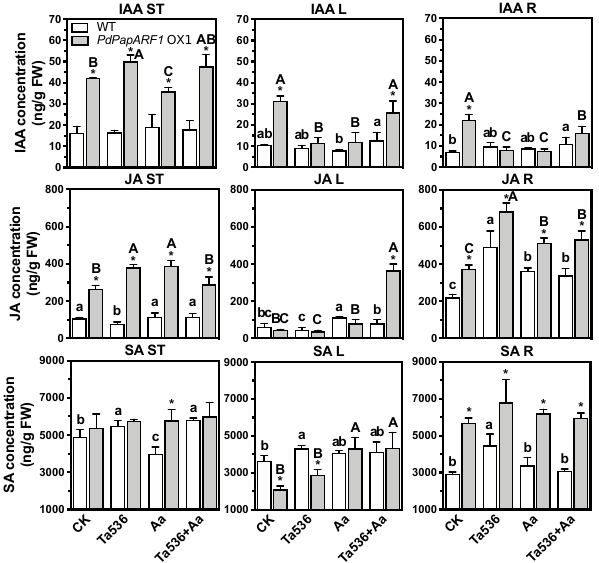
Figure 4. The concentrations of indole acetic acid (IAA), jasmonic acid (JA), and salicylic acid (SA). The hormone concentrations of three poplar compartments, the shoot tip (ST), inoculated leaves (L), and root (R) under no treatment (CK) or fungal treatments (Ta536, Aa, or Ta536+Aa) are shown. FW, fresh weight. Different capital letters represent significant differences among the OX plants treated with different inoculations; different lowercase letters represent significant differences among the WT plants treated with different inoculations; * significant difference between OX and WT plants undergone the same inoculation. Insignificant differences are not marked. All significances were at p < 0.05. All experiments were performed with three biological replicates with each replicate pooled of three plants. The replicates of OX plants were the clones of the line OX1.